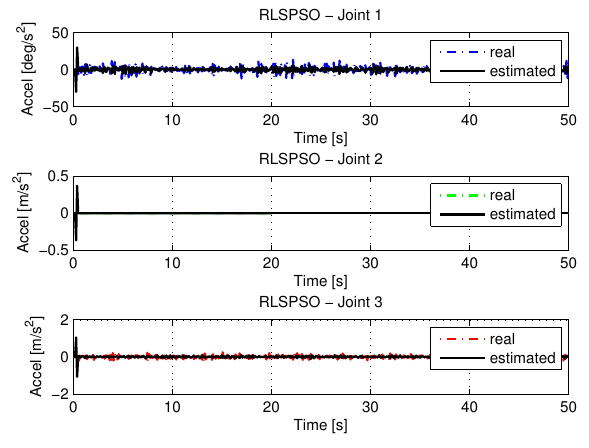
Figure 36. Accelerations of joints with RLSPSO with noise.